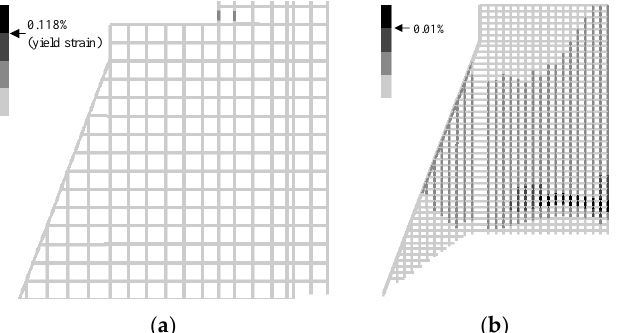
Figure 28. Strain distribution of the reinforcing bars (TYPE-A, wave A, reinforcing range 60%): ( a ) existing part: ( b ) reinforcement part.